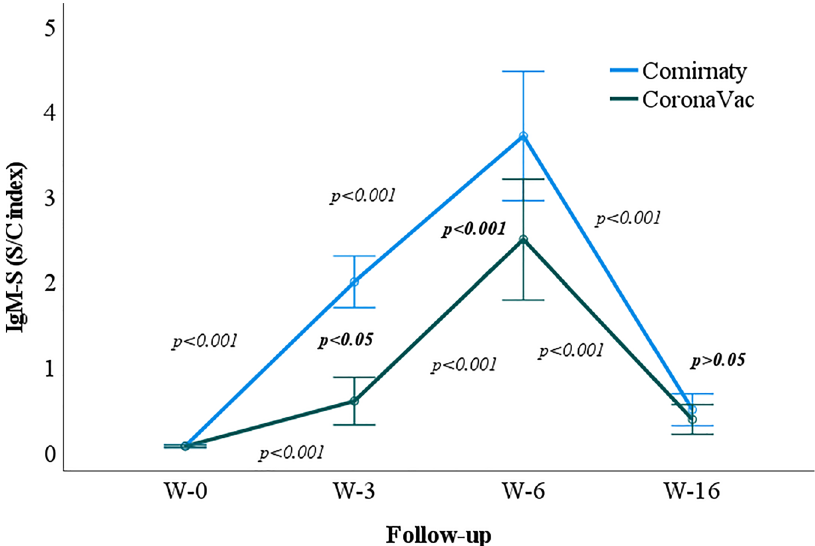
Figure 4. Geometric mean of the IgM-S S/C index in Comirnaty and CoronaVac vaccine recipients at weeks 0, 3, 6, and 16. W-0, Week zero; W-3, Week three; W-6, Week six; W-16, Week 16. Regular p value indicating the difference between two sampling points. Bolded p values indicating the difference between Comirnaty and CoronaVac at the respective